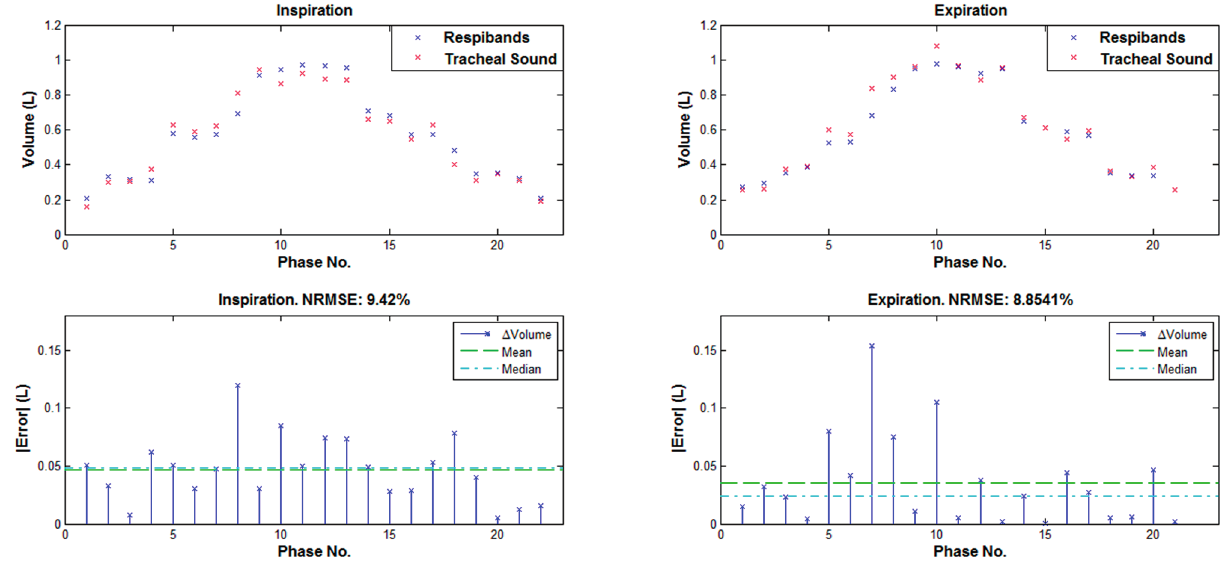
Figure 6. Top: Reference and estimated volumes for the same example as in Figure 5. Bottom: The corresponding NRMSE